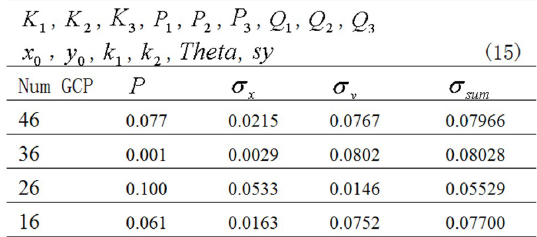
Table 2: The assessment using check points for 15 parameters.